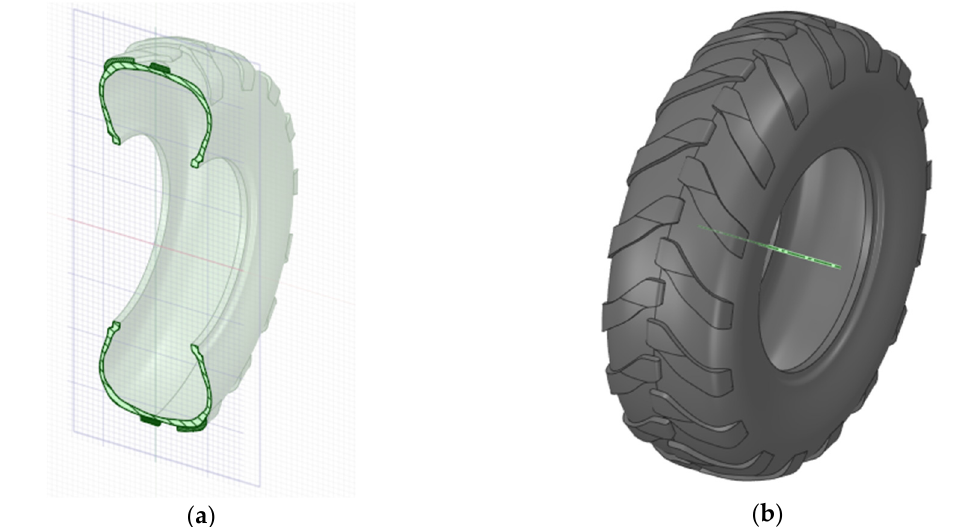
Figure 4. 3D tyre section (in this case: 420 / 85 R24) modelled in Ansys SpaceClaim 2019 R3 ( a ) and in Ansys SpaceClaim 2019 R3 ( b ).